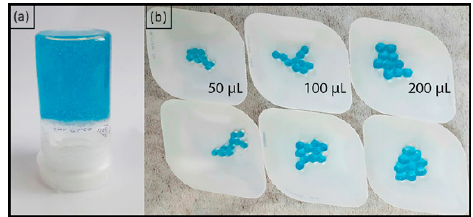
Figure 1. ( a ) Cu/CS hydrogel sample made from low molecular weight chitosan; ( b ) Cu/CS spherical hydrogel samples fabricated from high molecular weight chitosan with different volumes of added chitosan solution.